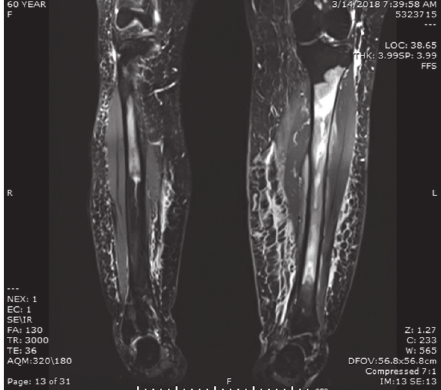
Figure 2: MRI of left tibia with/without IV